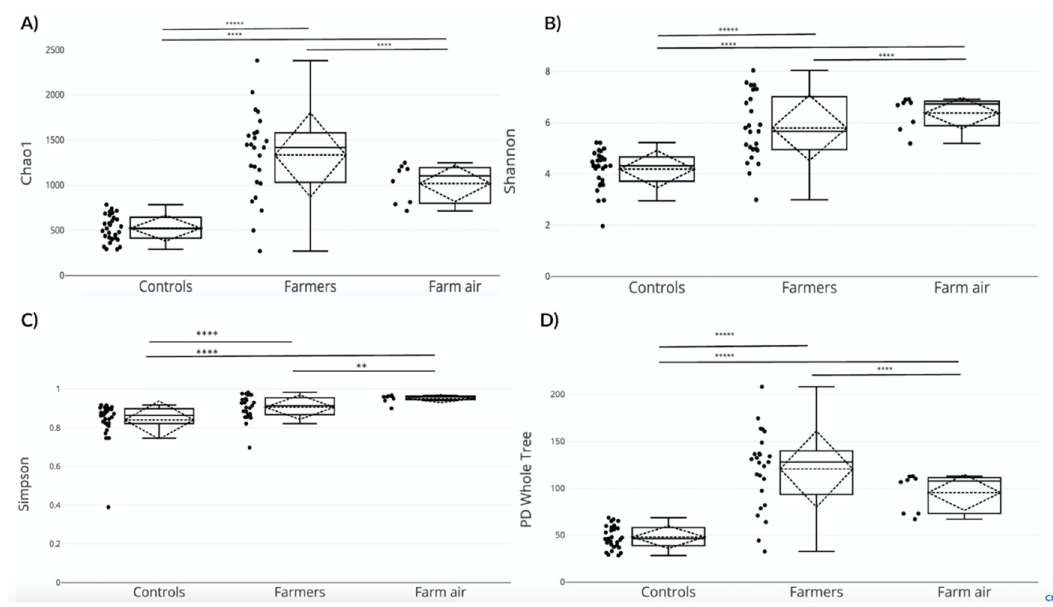
Figure 2. Alpha diversity analyses comparing nasopharynx samples of pig farmers and non-exposed controls and air samples from pig buildings. Analyses include ( A ) Chao1, ( B ) Shannon, ( C ) Simpson, and ( D ) phylogenetic diversity (PD) Whole Tree. The boxplots represent the maximum, minimum value, first and third quartile values, and the median value. The mean values with the standard deviation are represented by the dotted lines. The asterisks (*) indicate the statistical significance of the Mann-Whitney U tests (ns p > 0.05; ** p ≤ 0.01; **** p ≤ 0.0001).